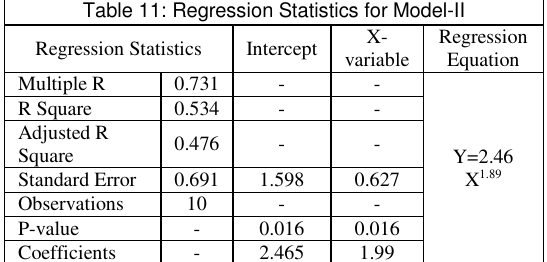
Table 11: Regression Statistics for Model-II